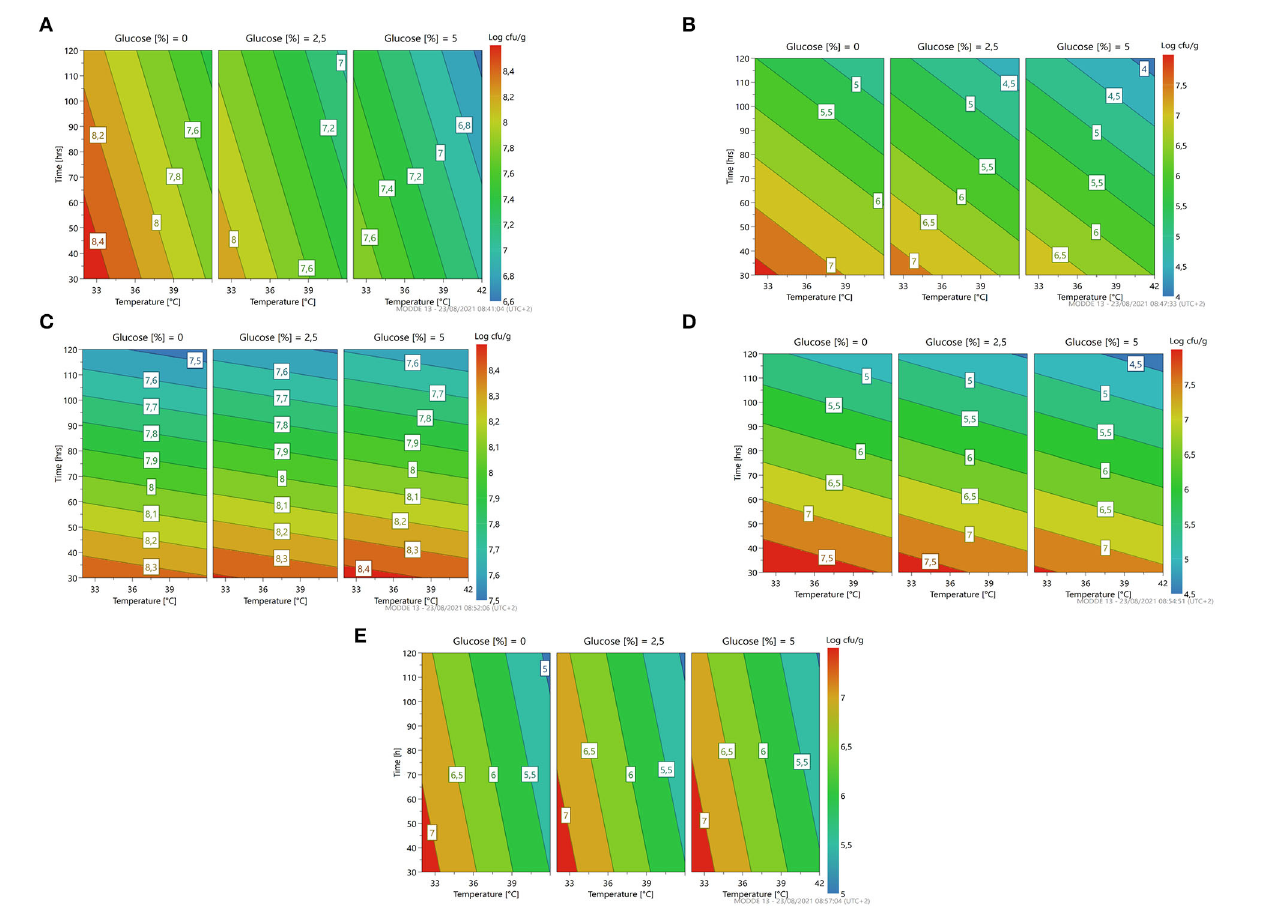
FIGURE 5 | A response contour plot of concentration (Log cfu/g) of Lacticaseibacillus rhamnosus 1473 (A) ; Lacticaseibacillus paracasei 4186 (B) ; Lacticaseibacillus casei 2240 (C) ; Lactiplantibacillus plantarum 4932 (D) ; Pediococcus acidilactici 3992 (E) in samples with seeds, with time and temperature as main factors and with glucose